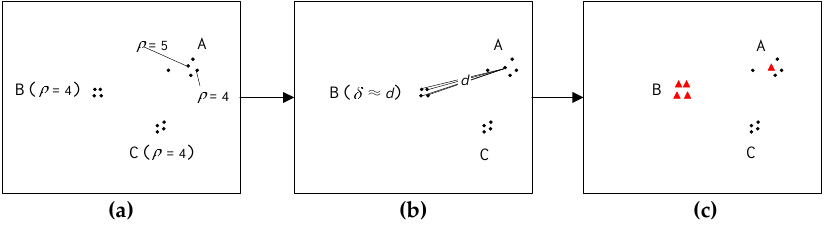
Figure 3. An example of wrong clustering centers. ( a ) The initial points; ( b ) For each point, calculate the minimum distance; ( c ) Choose the wrong centers.